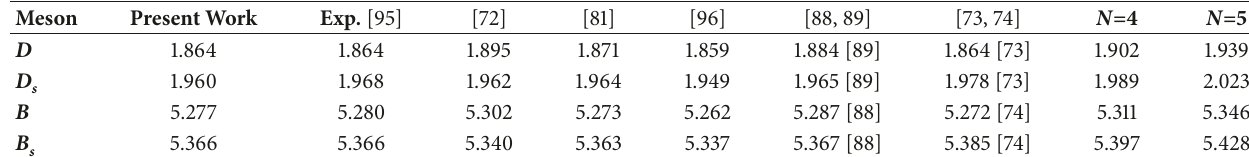
Table 2: Masses for pseudoscalar ( 2 S +1 𝐿 𝐽 = 1 𝑆 0 ) mesons in GeV. 𝑎 = 0.00085 GeV 3 , 𝑏 = 0.01614 GeV 2 , and 𝑐 = 0.7 .